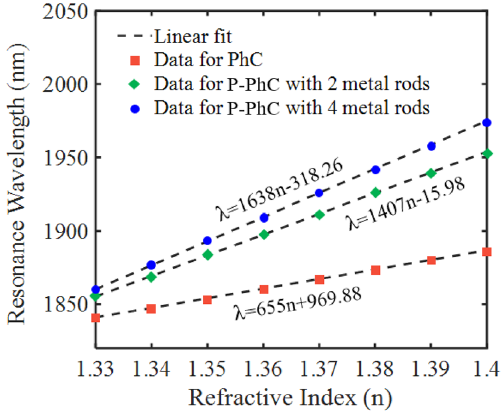
Figure 9. Resonance wavelength of three sensor structures as a function of analyte refractive